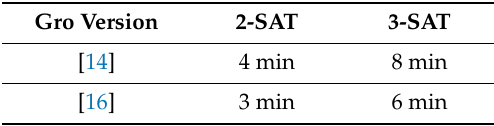
Table 4. Run times as a function of complexity and Gro